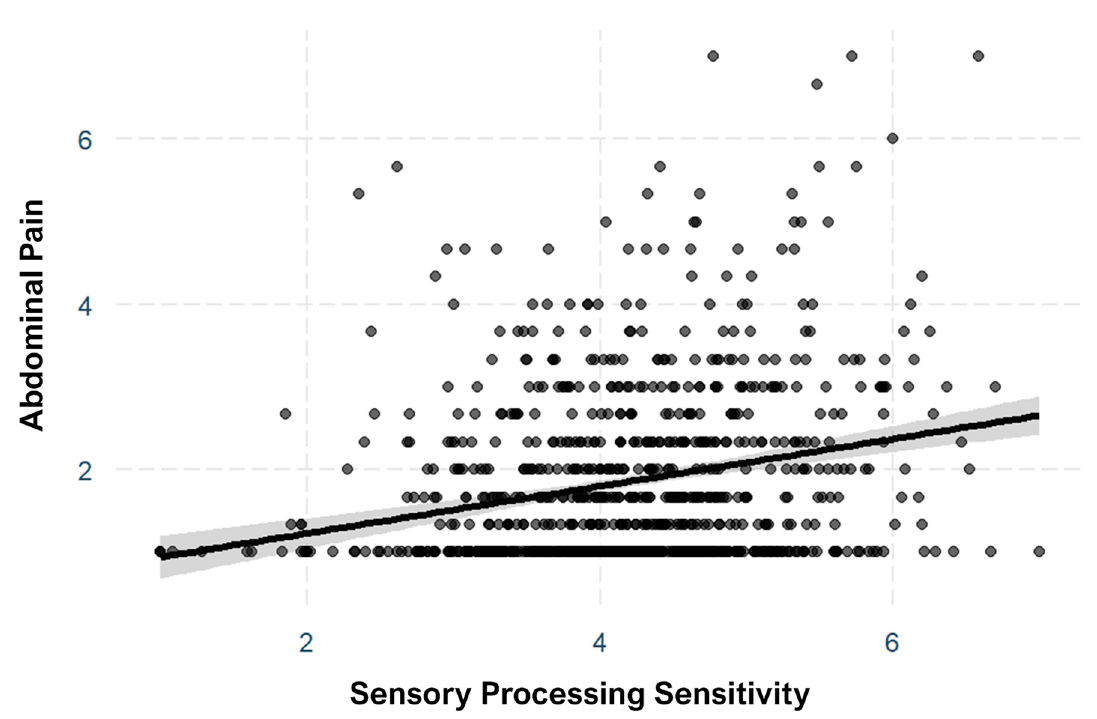
Figure A2. A Plot of the Regression Line Showing the Relationship between the Abdominal Pain and Sensory Processing Sensitivity.